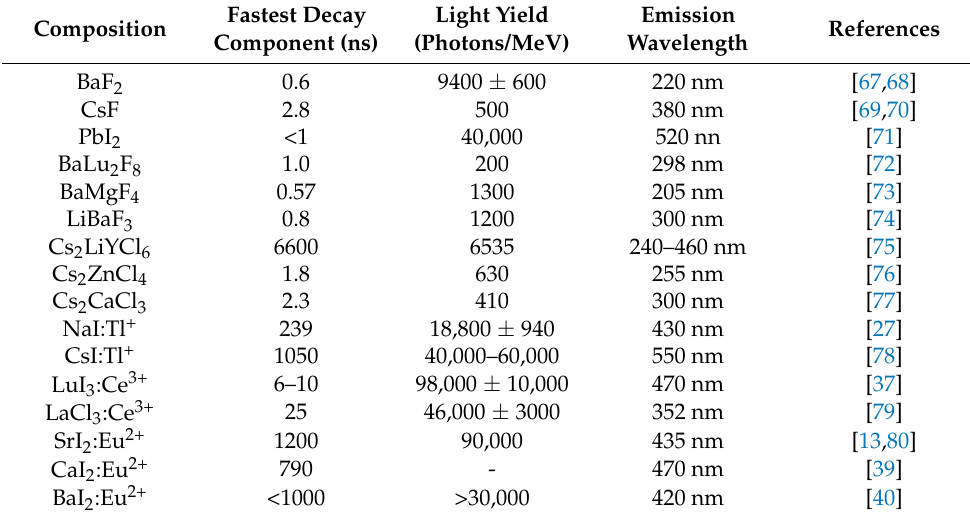
Table 1. A list of different halide inorganic materials and their scintillation characteristics.